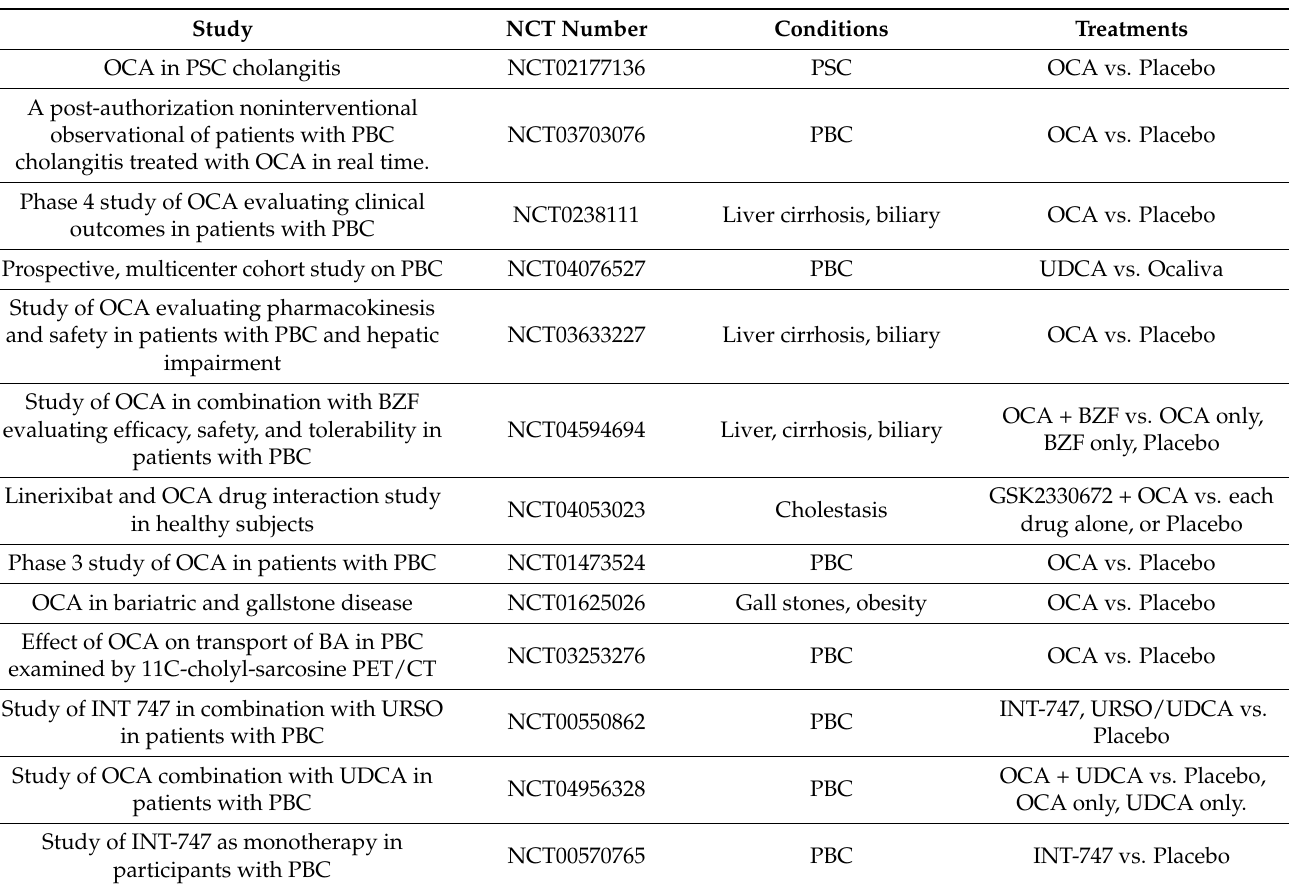
Table 2. Clinical trials for testing FXR ligands or FXR-related targets in PBC/PSC patients, as listed in clinicaltrials.gov